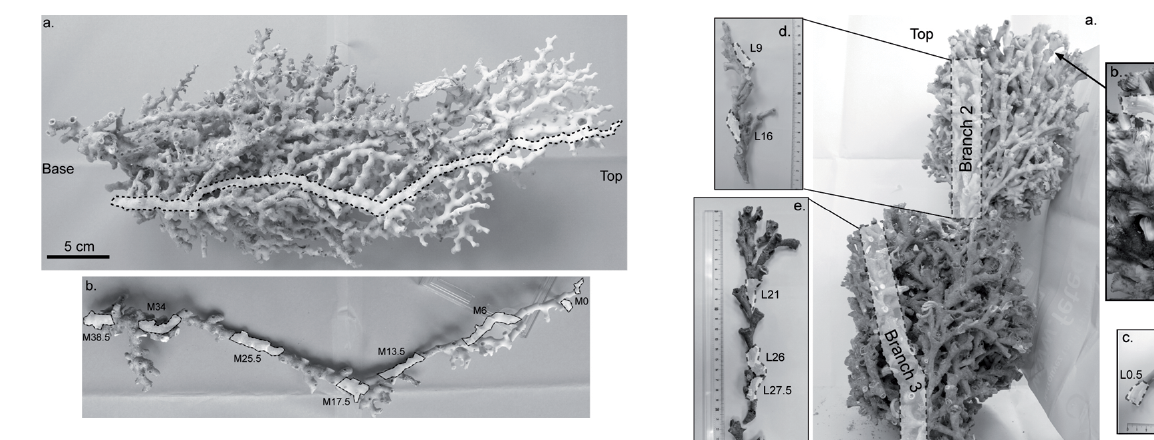
Fig. 2. Subsampling of Madrepora oculata specimen. (a) Extrac- tion of a continuous branch along the coral, (b) location of samples analyzed for 210 Pb- 226 Ra chronology.